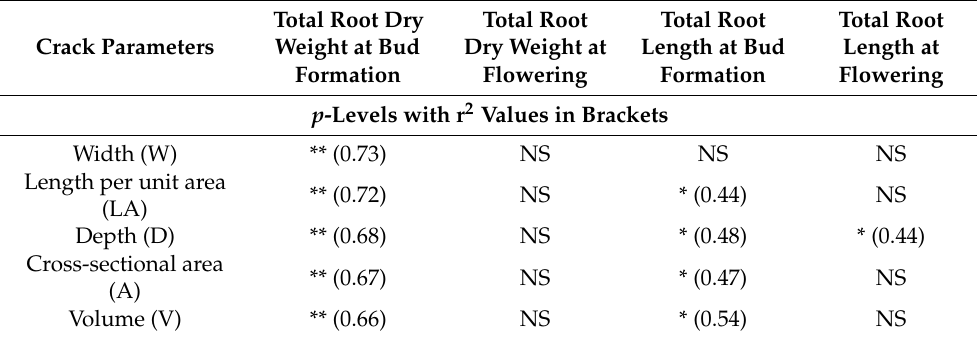
Table 5. Significance of relationships of crack parameters to root dry weight and total root length at